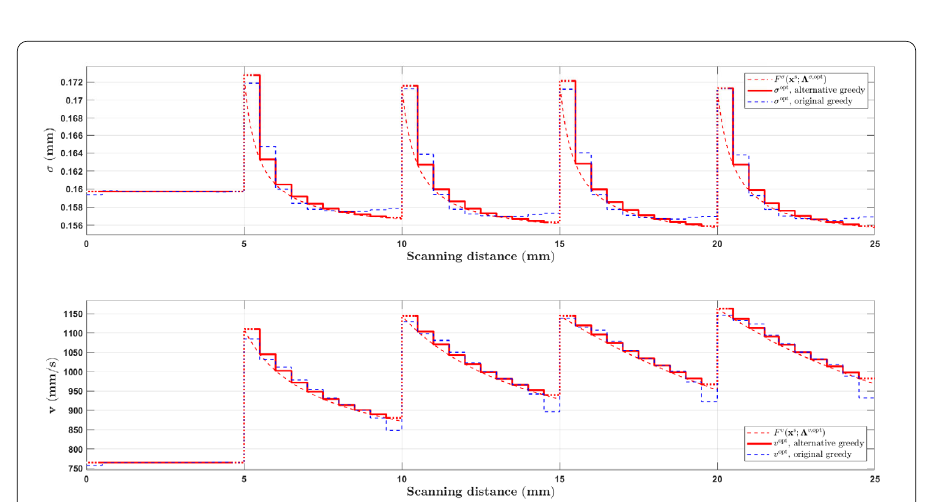
Figure 14 The solution as obtained by the second greedy algorithm. The solution is a piecewise constant discretization of the beam parameter functions F σ and F v in (9). The solution obtained by the first greedy algorithm is included for